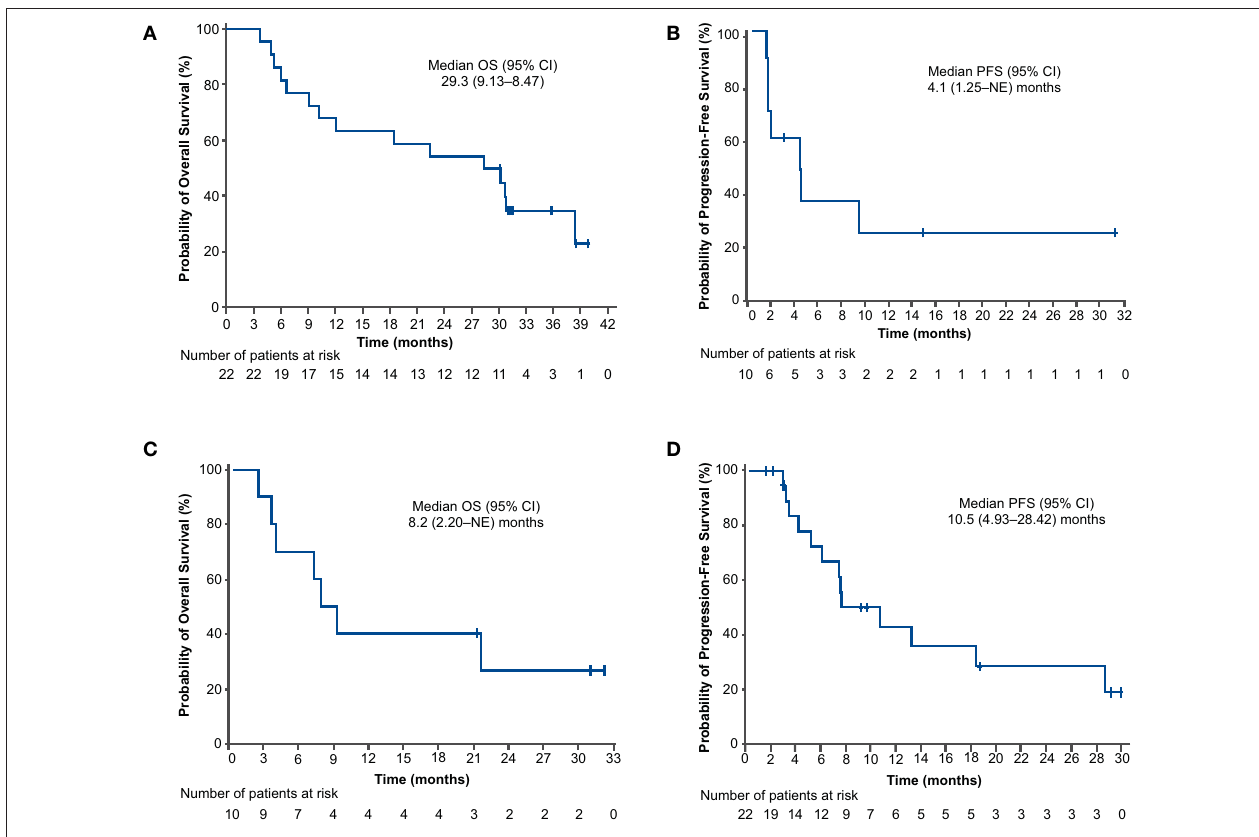
FIGURE 2 | Progression-free survival (A,C) and overall survival (B,D) outcomes in the concurrent cohort (dose-finding and expansion parts; A,B ) and delayed cohort (dose-finding part only; C,D ). Two patients in the concurrent cohort and 4 patients in the delayed cohort did not receive nivolumab. CI, confidence interval; NE,